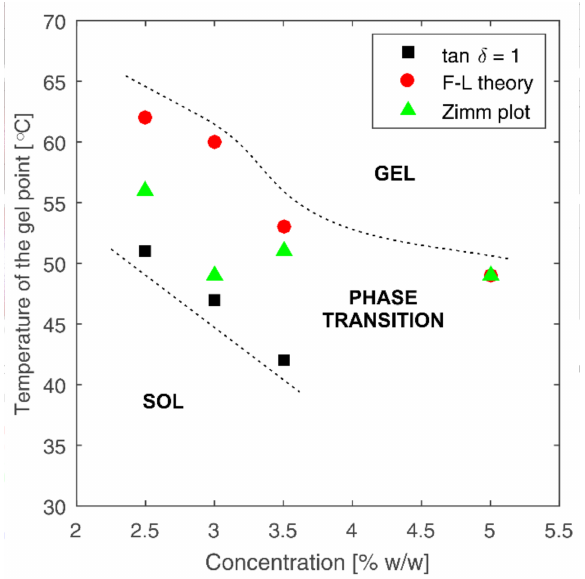
Figure 5. Gelation temperatures for all tested samples at different concentrations determined on the basis of rheological and light scattering data.